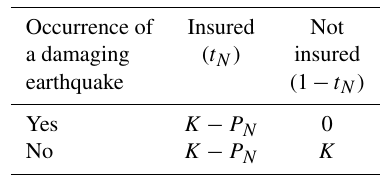
Table 3. The four different wealth levels of a homeowner, consid- ered in this study, according to the occurrence of a damaging earth- quake and the insurance cover. The quantities t N and 1 − t N repre- sent the share of homeowners insured and not insured, respectively.